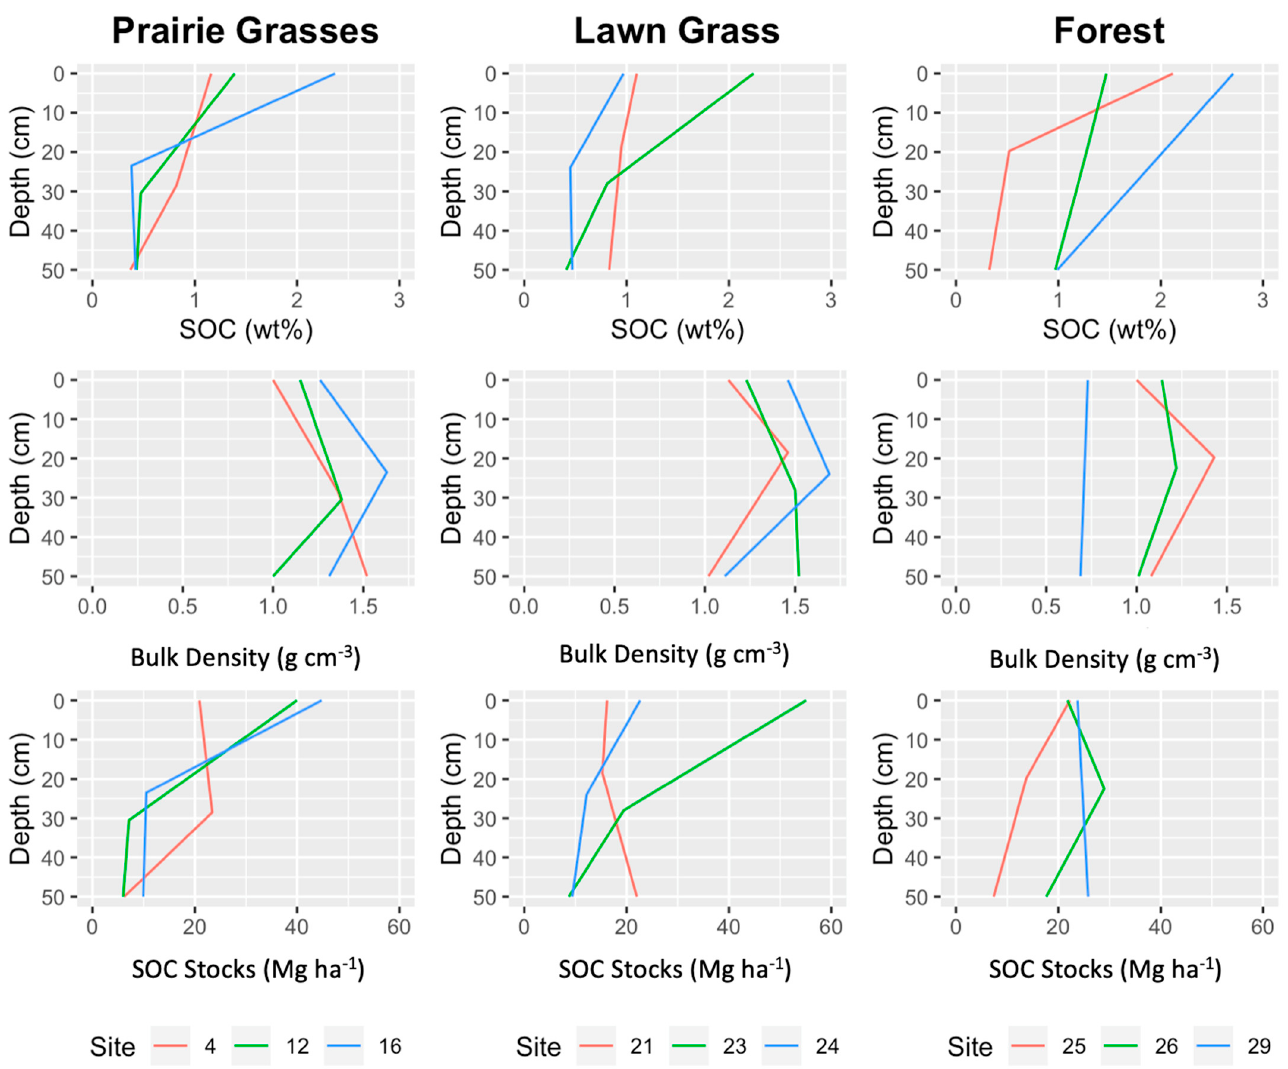
Figure 4. Distribution of SOC (wt%), Bd (g/cm 3 ) and SOC stocks (Mg/ha) with depth for soil pits in the prairie grass, lawn grass and forest. Table 2. Soil organic carbon (SOC, wt%), bulk density (Bd g cm − 3 ), and SOC stock (Mg ha − 1 ) sample mean (x ‐ bar), standard deviation ( s x ), and sample size ( n ) for the pits and auger holes of the soil horizon.